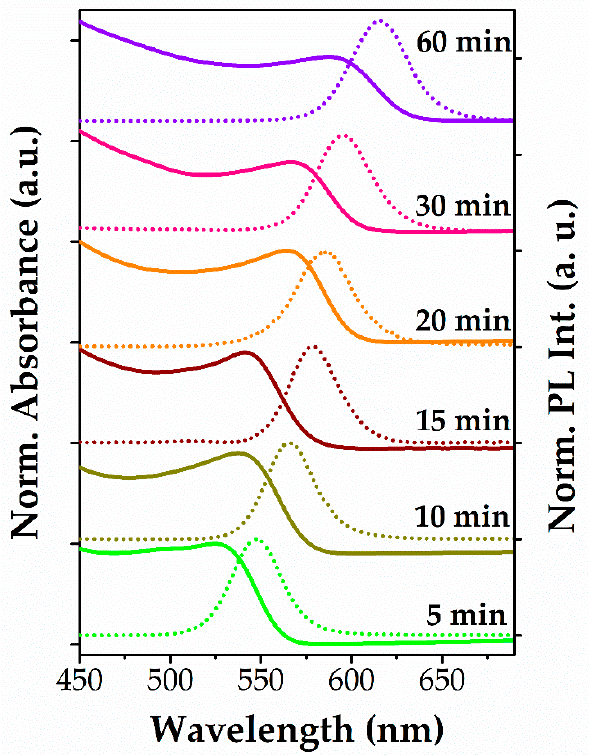
Figure 6. Normalized absorption and PL emission spectra for CdTe QDs via ex situ route, synthesized at different reaction times.